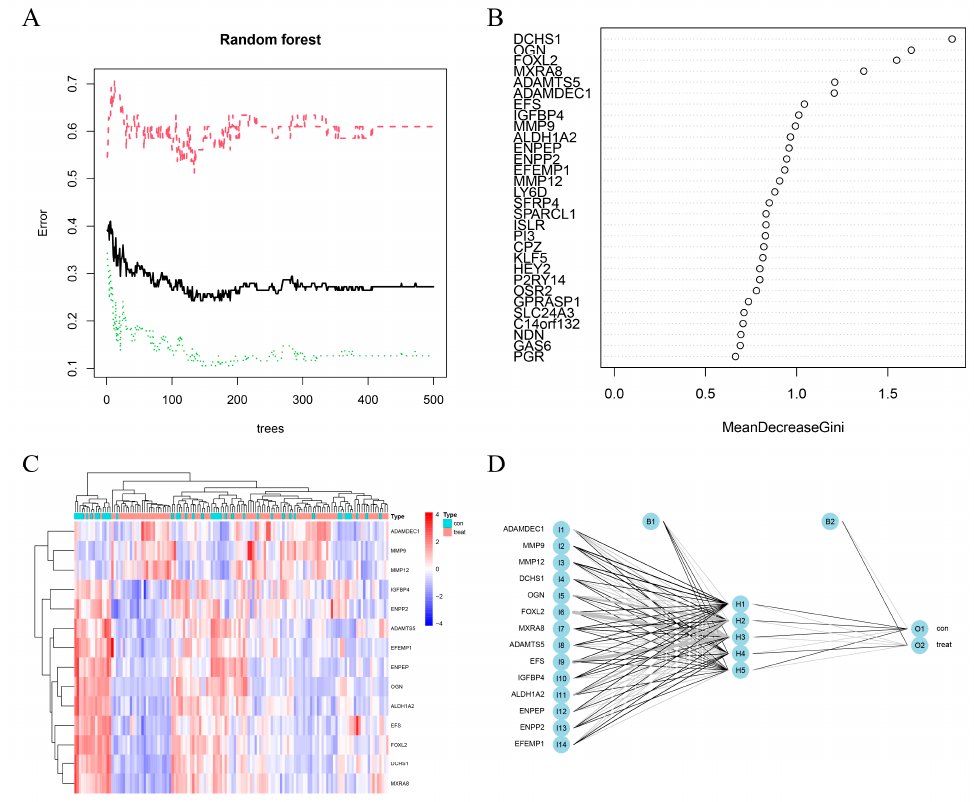
Figure 3. Selection of signature genes by machine learning and construction of a diagnostic prediction model by artificial neural network. ( A ) Construction of random forest. ( B ) Exploring signature genes of EC based on gene importance scores. ( C ) Heatmap of 14 characteristic DEGs. ( D ) Process of constructing artificial neural